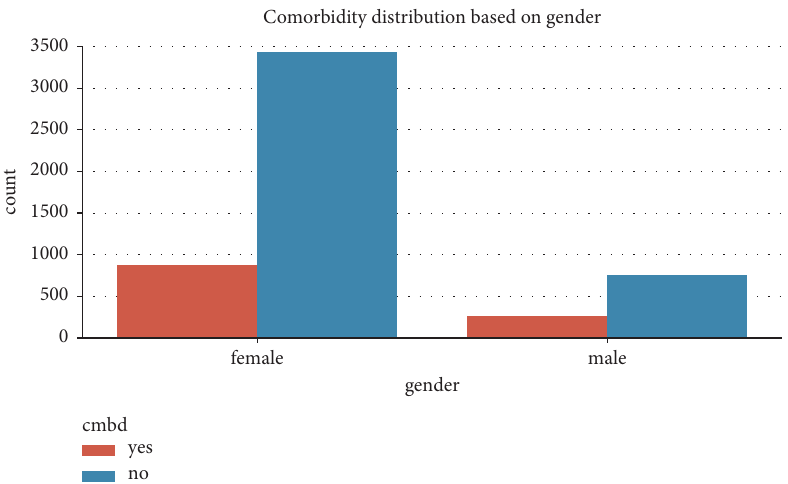
Figure 4: Comorbidity distribution among sampled